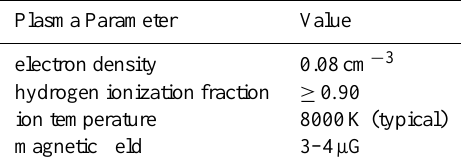
Table 1. Mean plasma parameters in Diffuse Ionized Gas (DIG) phase of the Interstellar Medium.